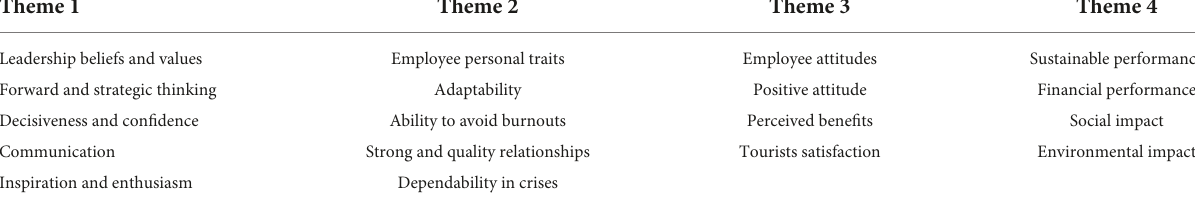
TABLE 2 Main themes of the study